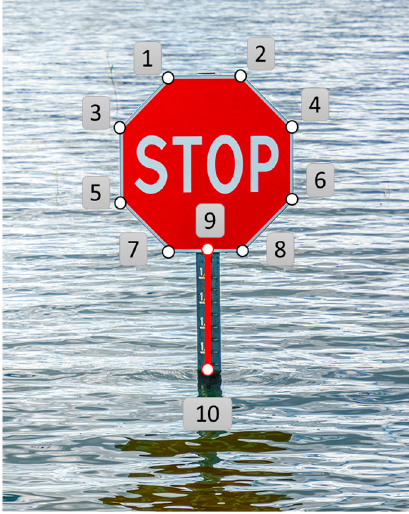
Figure 6. Illustration of the manual retrieval method. The points (1–10) indicate the critical edge for the sign shape and are used for dimension calculation.